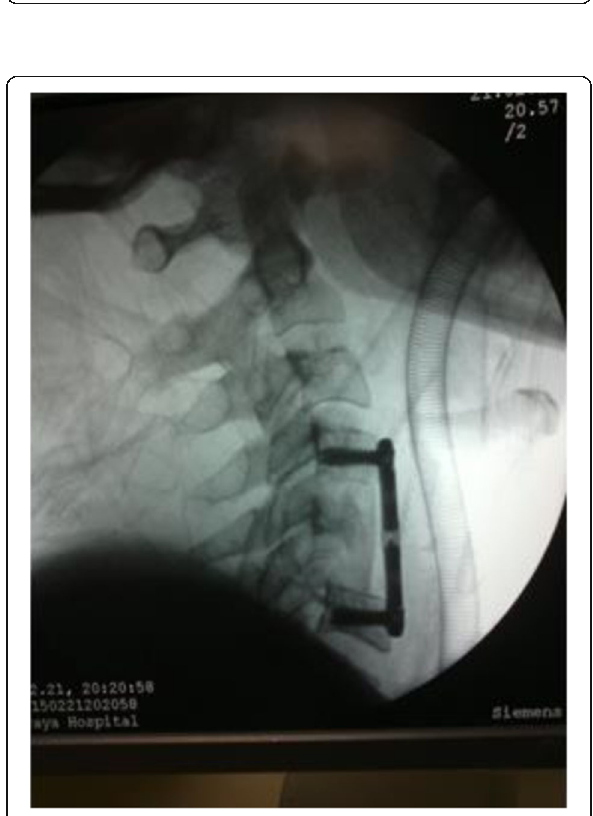
Fig. 2 Fluoroscopic image showing corpectomy of C5, iliac crest bone grafting, and C4 – C6 plating